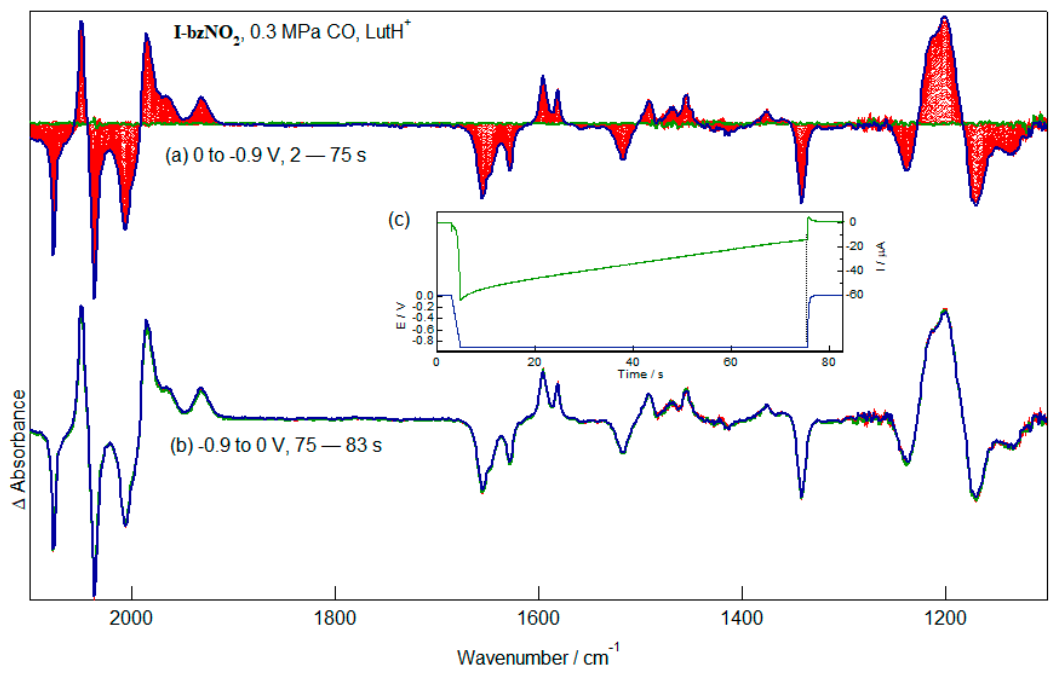
Figure 10. IR-SEC spectra recorded during (a) reduction and (b) re-oxidation of solutions of I-bzNO 2 (2 mM, CH 2 Cl 2 , 0.2 M TBAPF 6 ) in CH 2 Cl 2 with LutH + (ca. 50 mM) and saturated with CO (0.3 MPa).